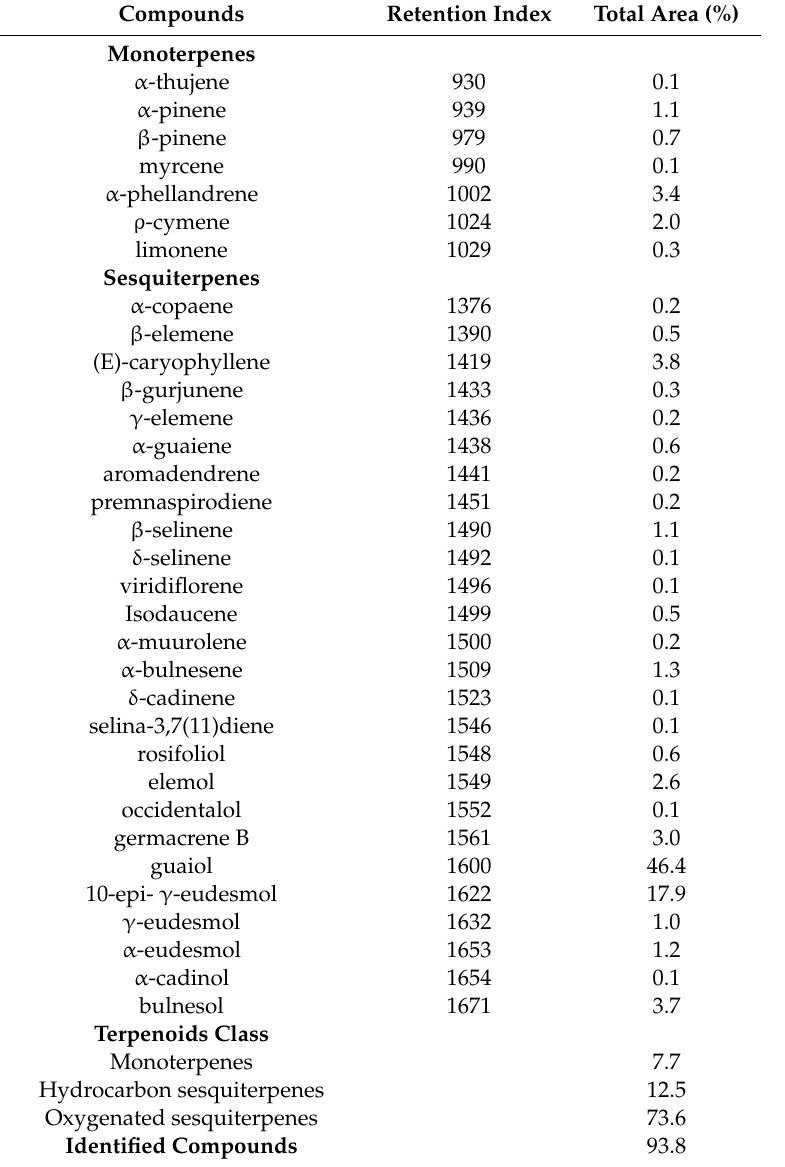
Table 1. Chemical composition of the Endlicheria bracteolata essential